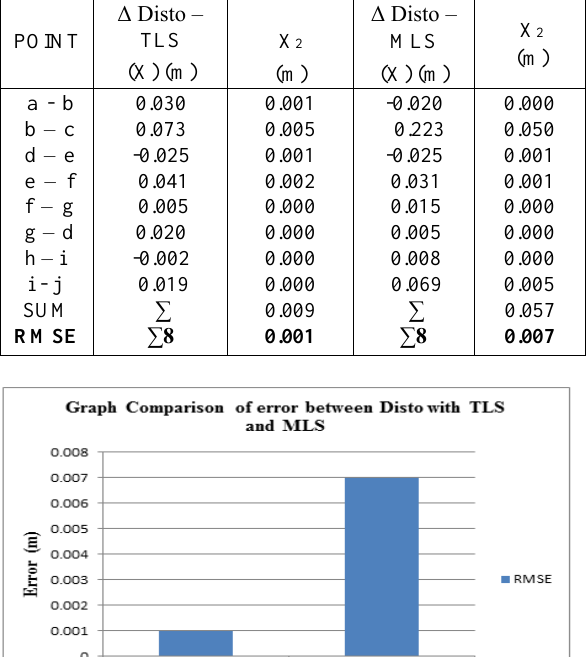
Table 3: Comparison measurement between Distometer, TLS and MLS.